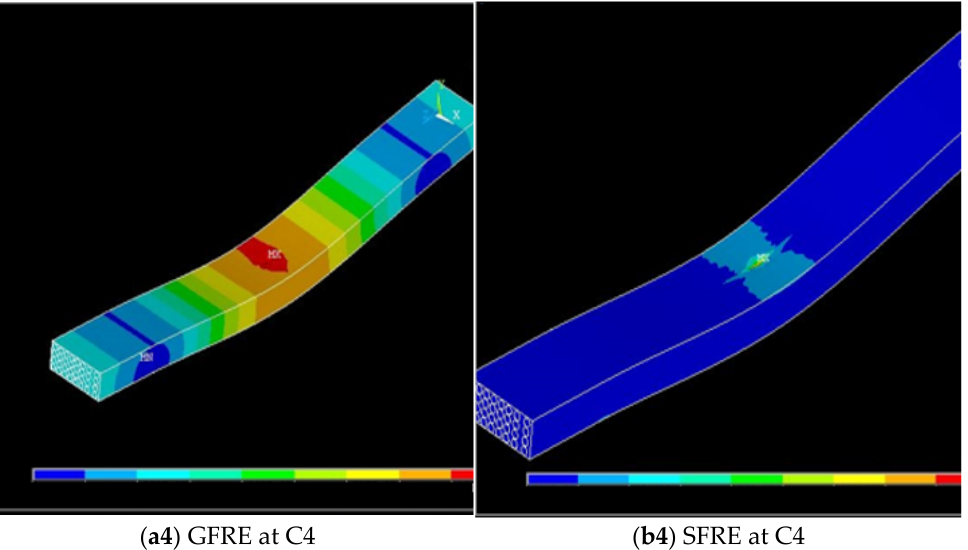
Figure 17. ( a1 – a4 ) Stress distribution of GFRE at different conditions and ( b1 – b4 ) stress distribution of SFRE at different conditions.